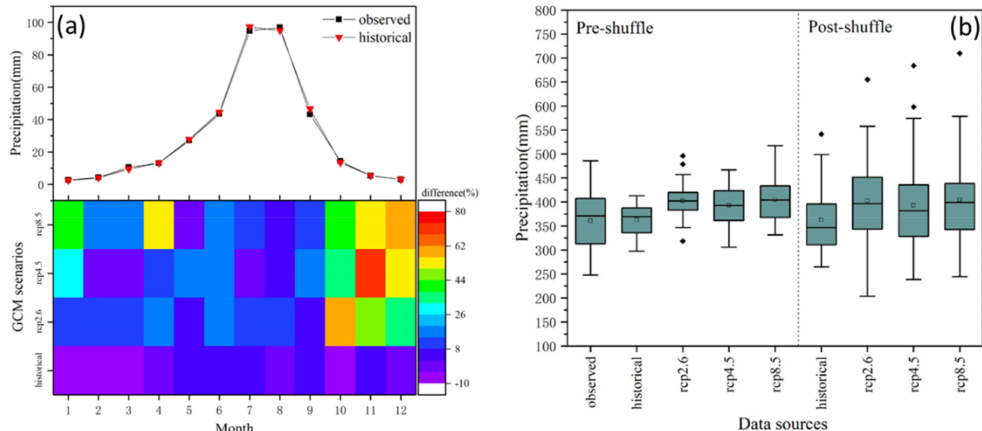
Figure 11. ( a ) Comparison, in terms of monthly precipitation, between the statistical values of the observed data and the downscaled GCM data with proposed method in the Huangfuchuan Basin; ( b ) comparison, in terms of annual precipitation, between the statistical values of the observed data, the downscaled GCM data without using shu ffl e procedure (pre-shu ffl e) and the downscaled GCM data with using shu ffl e procedure (post-shu ffl e) in the Huangfuchuan Basin. The historical period is 1976–2005. The projection period is